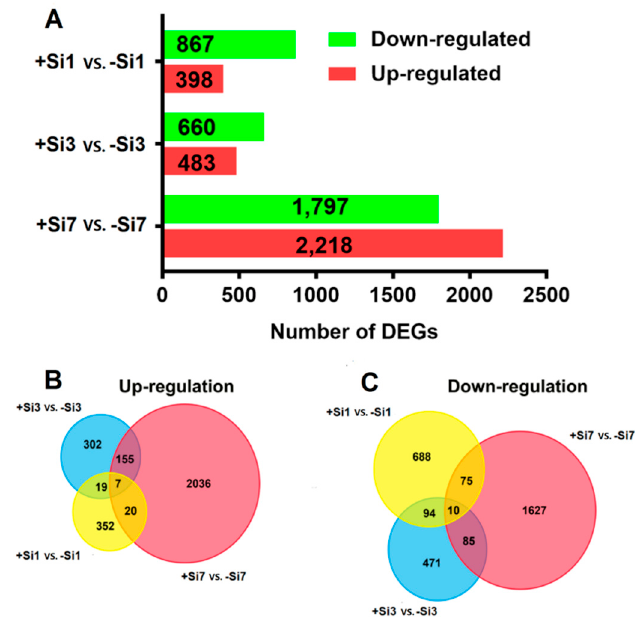
Figure 3. Differentially-expressed genes (DEGs) in different paired-comparisons. ( A ) The numbers of DEGs identified from the three comparisons. ( B , C ) Venn diagram for DEGs identified in different comparisons. +Si1, +Si3, and +Si7 represents silicon (Si)-treated (+Si) samples obtained at 1, 3, and 7dpi, respectively; − Si1, − Si3 and − Si7 represents non-Si-treated ( − Si) samples obtained at 1, 3, and 7dpi, respectively.